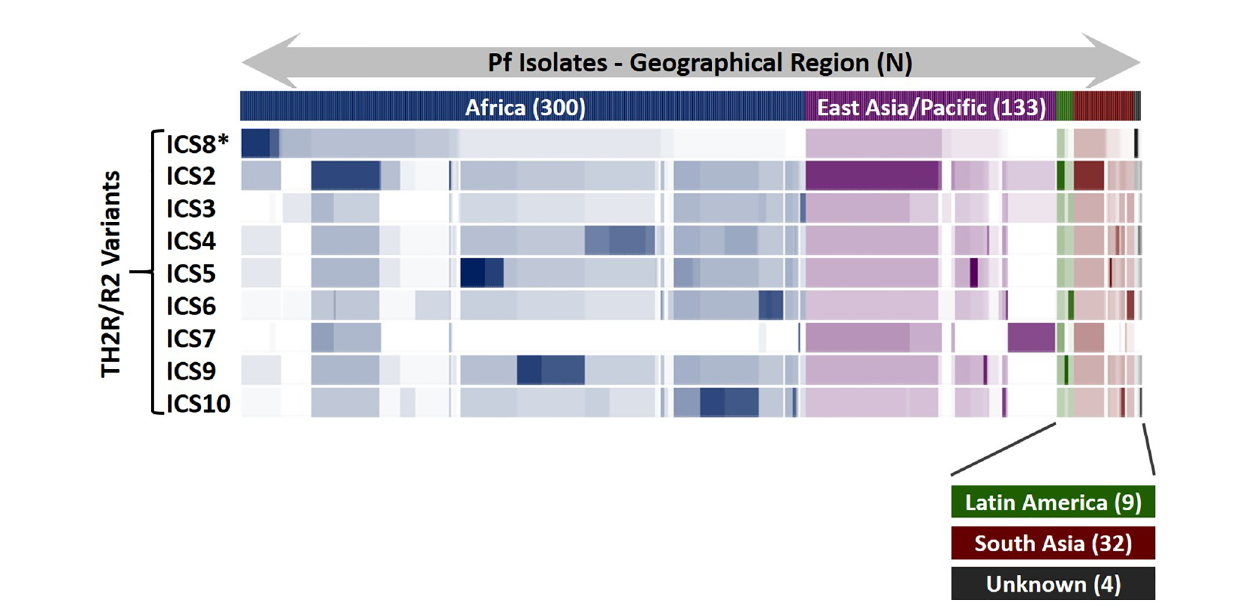
FIGURE 5 | PfCSP Isolate Coverage Map for TH2R/R2 Epitope Cross-Conservation. An epitope sequence cross-conservation analysis was performed to determine the number of matching predicted epitopes between each ICS and the 478 PfCSP isolates evaluated to identify the ICS. The Pf isolates are shown horizontally, grouped by geographical region, and the number of isolates for each geographical region (N) is indicated. Areas of darker colors indicate higher numbers of matching predicted epitopes while white areas indicate a lack of matching predicted epitopes. *ICS8 is the 3D7 sequence and identical to the C3